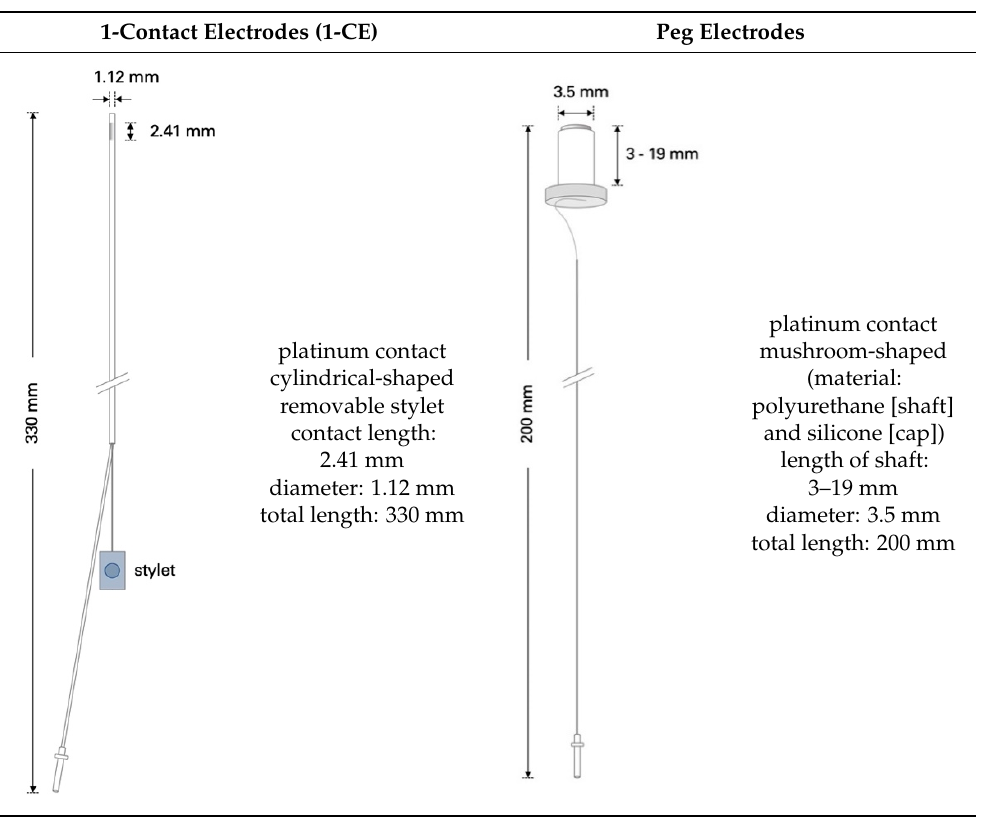
Figure 2. Overview of epidural electrode cases between 2011 and 2021. Number of epidural electrode cases in our institution per annum. Abbreviations: 1-CE = 1-contact electrodes. Between 2015 and 2019, when the use of cylindrical 1-CE emerged, there were also surgical cases in which a combination of these epidural electrodes was utilized. Table 1 shows an overview of the technical characteristics of the 1-CE and Peg electrodes. Table 1. Technical characteristics of 1-CE and Peg electrodes.